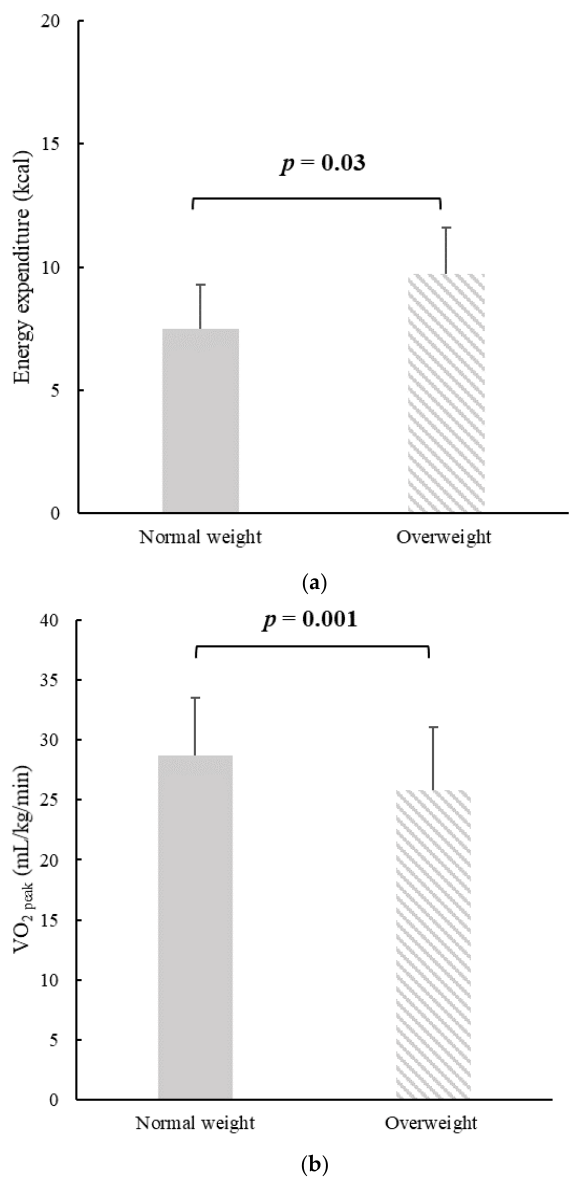
Figure 2. Comparison of mean ( a ) energy expenditure, ( b ) predicted oxygen uptake at peak of exercise between the study groups.